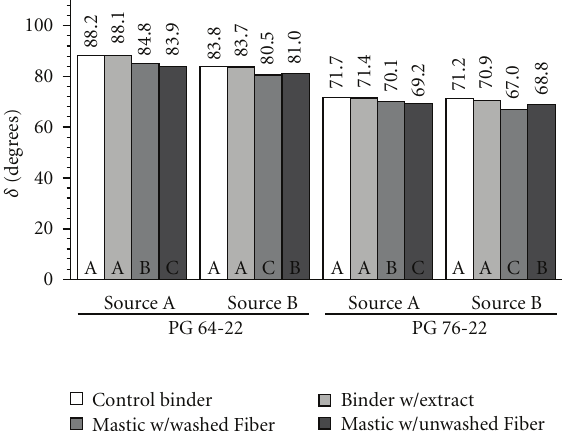
Figure 2: Viscosity of binders with and without finish extract (no fibers) at 135 ◦ C.